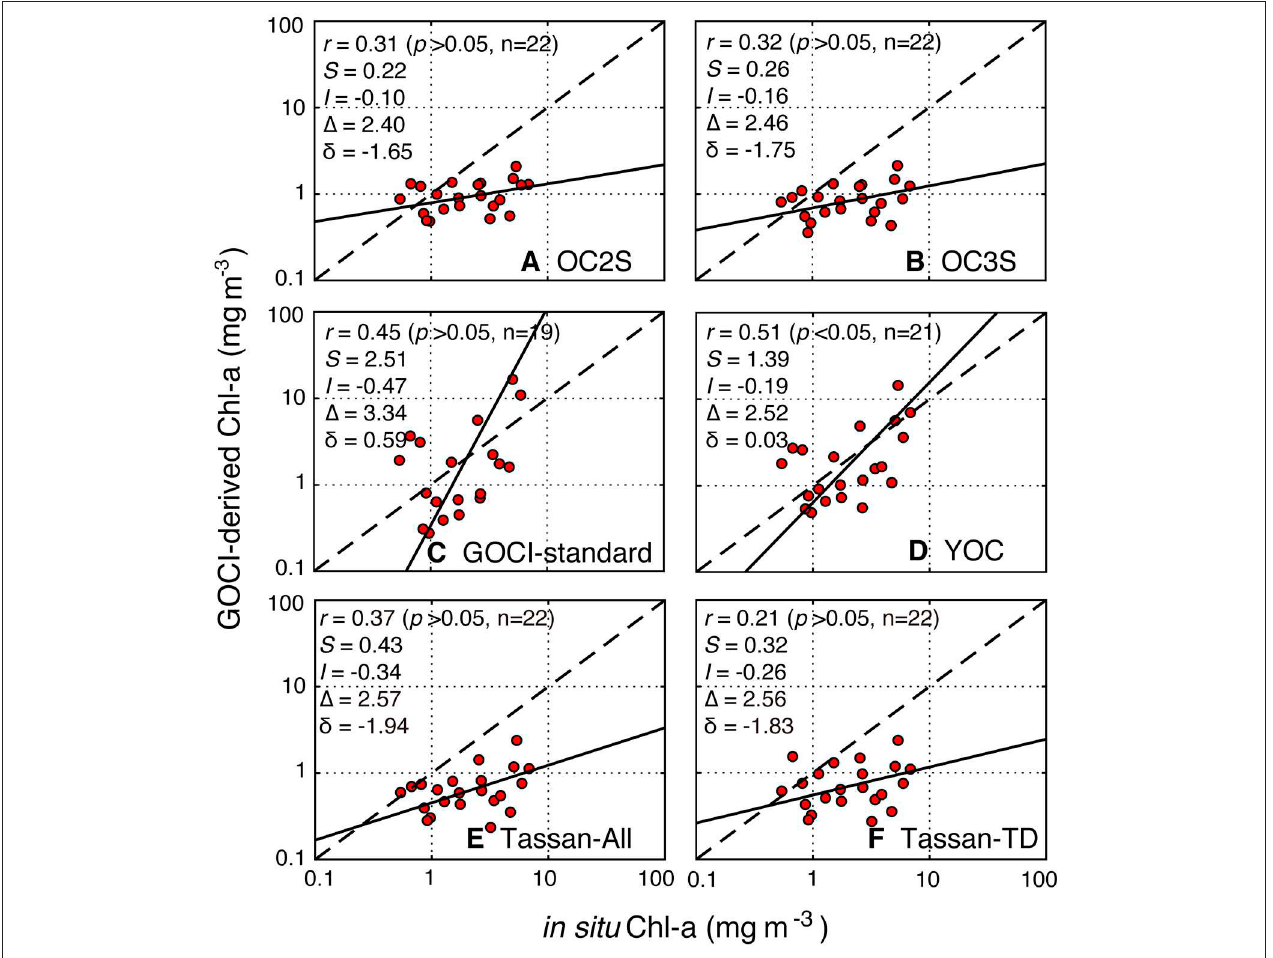
FIGURE 6 | Scatter plots between in situ Chl-a and GOCI-derived Chl-a for the six algorithms: (A) OC2S, (B) OC3S, (C) GOCI-standard, (D) YOC, (E) Tassan-All, and (F) Tassan-TD. The dashed and solid black line mark the 1:1 line and the Type-2 linear regression fit, respectively.